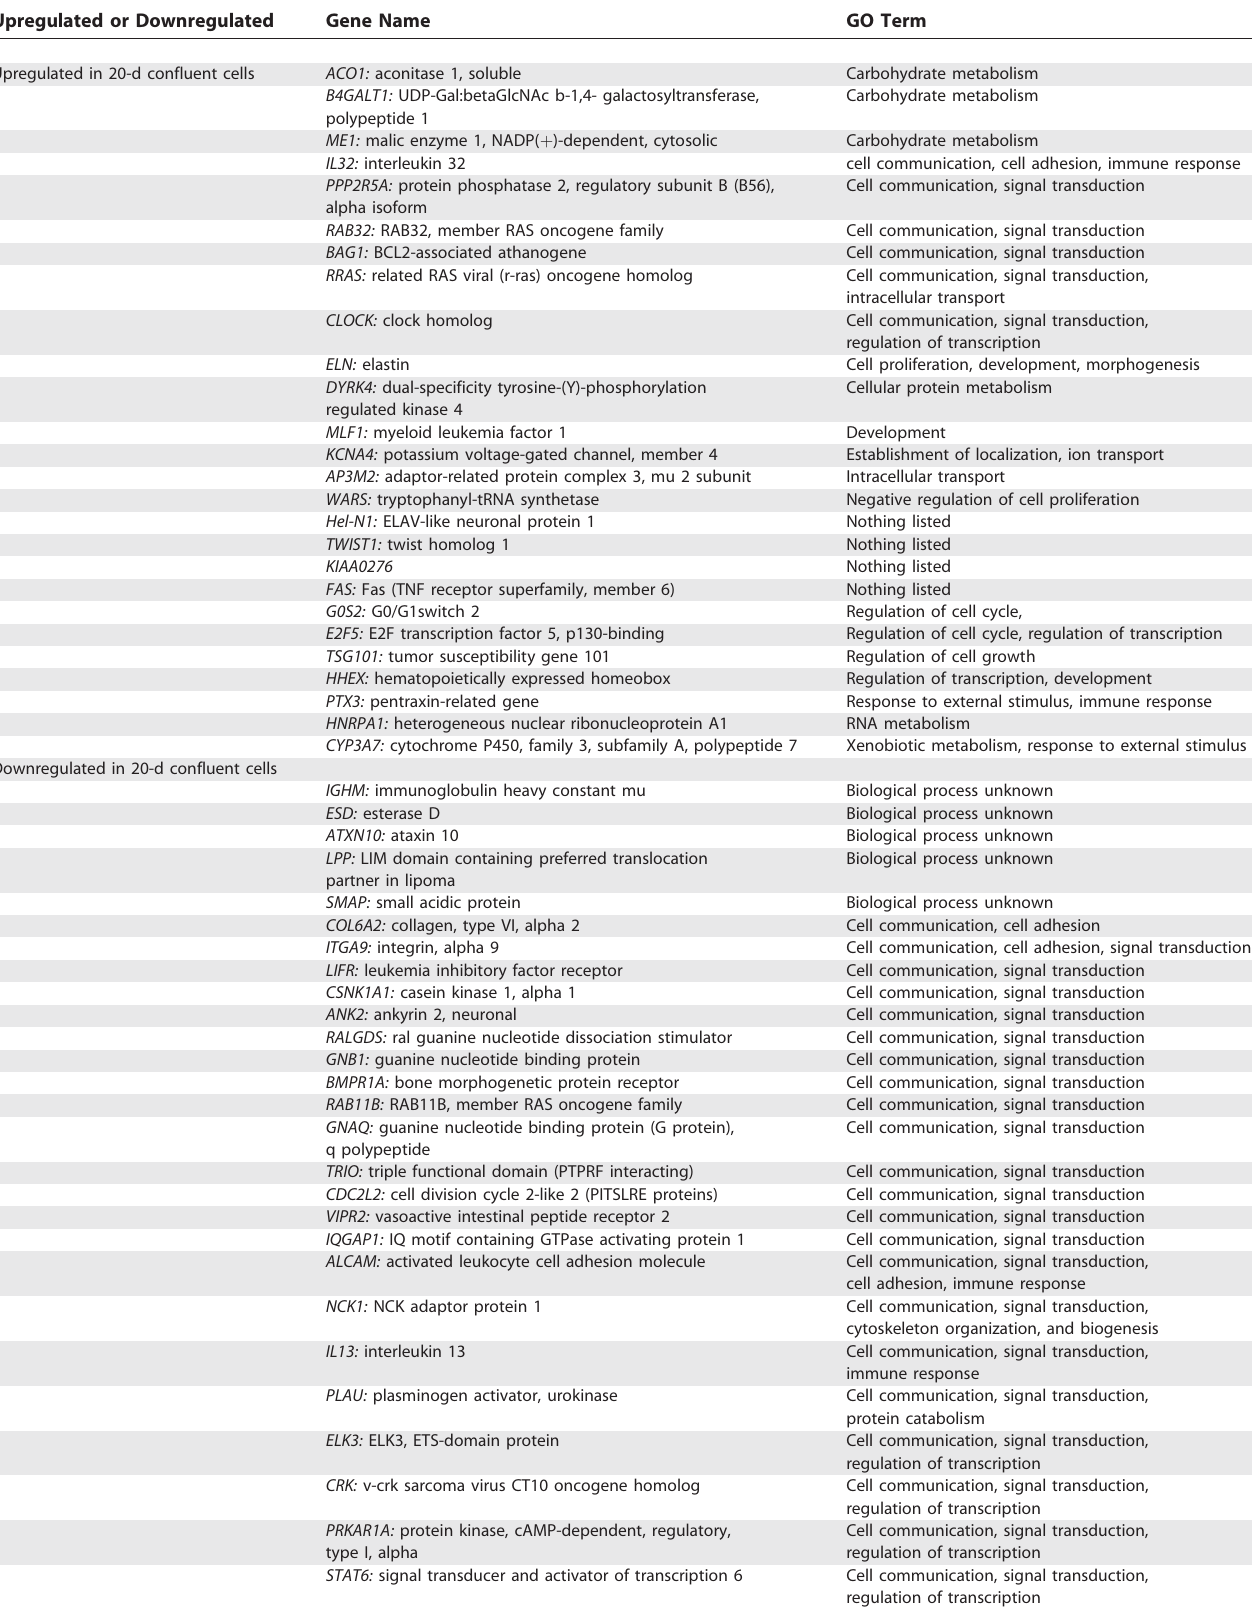
Table 3. Genes Regulated by Quiescence for Longer Periods of Time Upregulated or